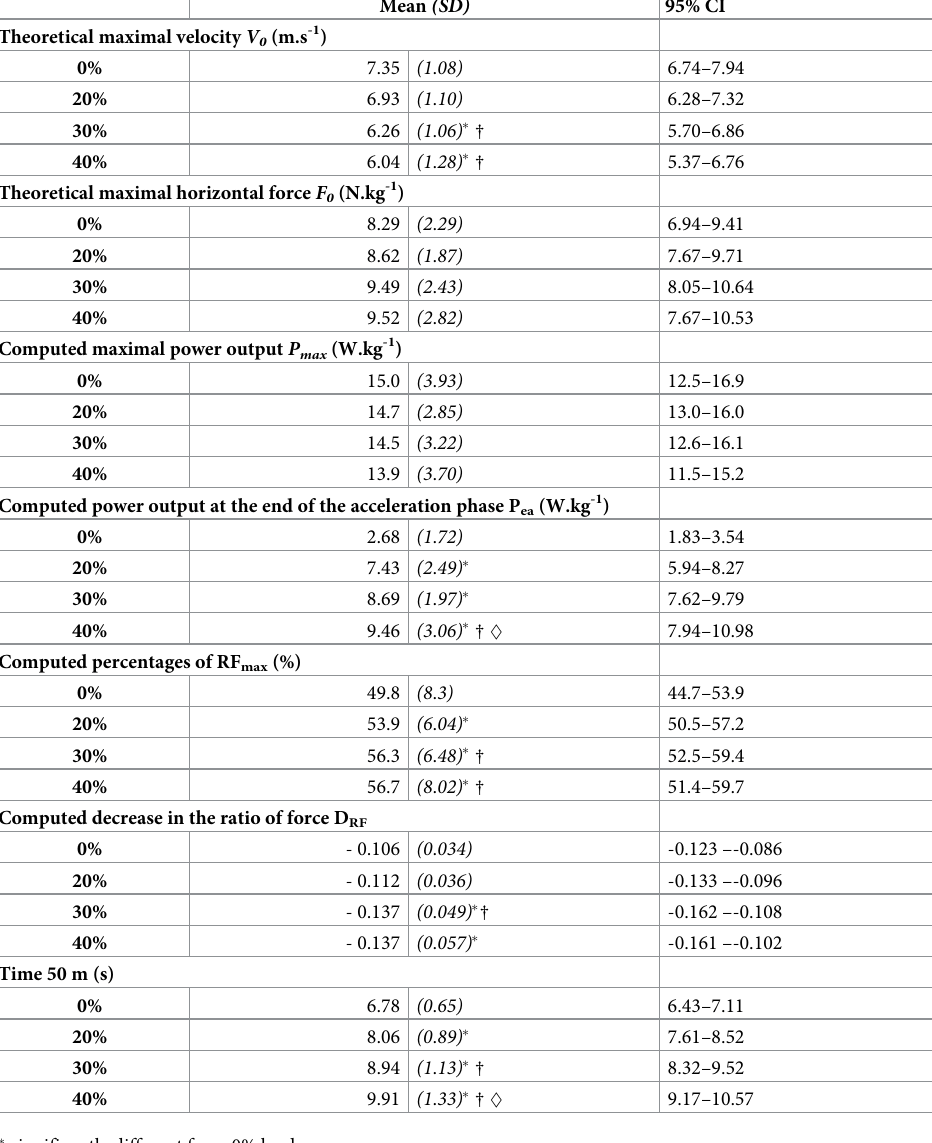
Table 1. Sprint running mechanics during the entire sprint acceleration. Data are presented as mean (SD) and 95% confidence intervals are reported for each load (0%; 20%; 30%;